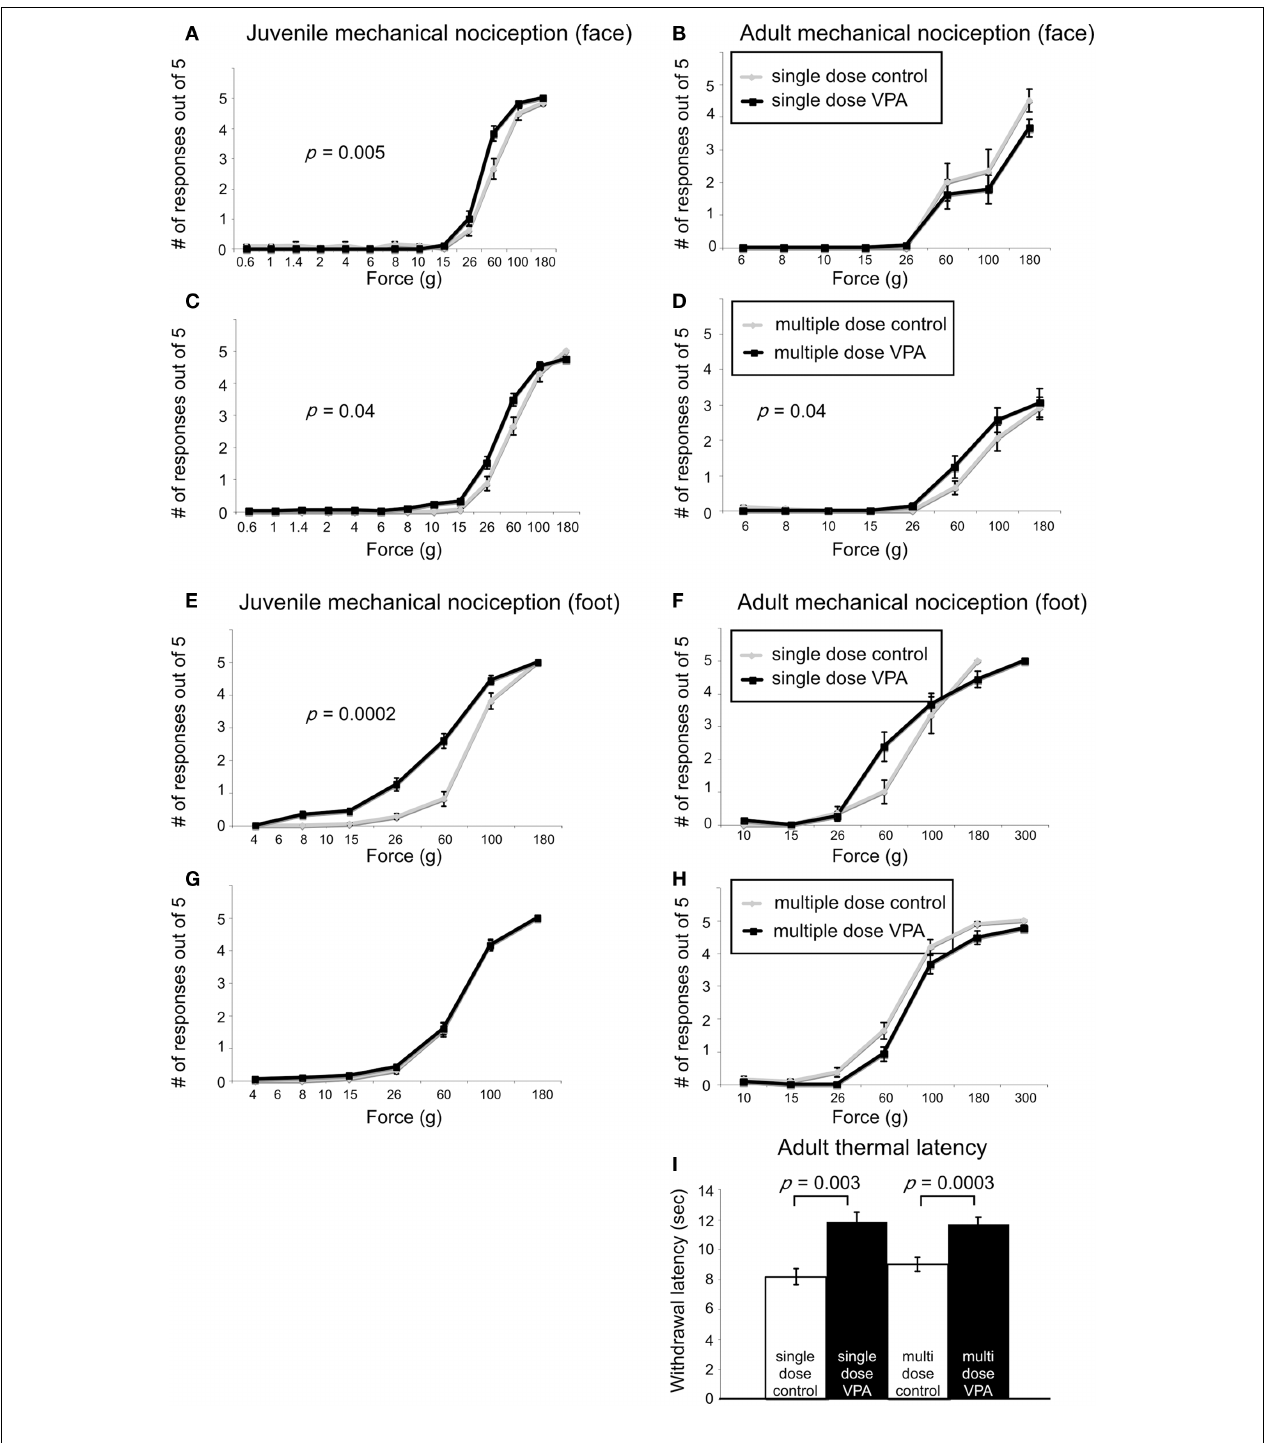
FIGURE 3 | Effect ofVPA treatment on nociceptive behavior. (A–D). Stimulus response curves to mechanical stimulation of the vibrissae pad. Juvenile rats treated with a single dose ofVPA (A) show increased sensitivity to mechanical stimuli. (B) This effect was reversed in adults. Juvenile (C) and adult (D) rats treated with multiple doses ofVPA show increased sensitivity to mechanical stimuli applied to the face.